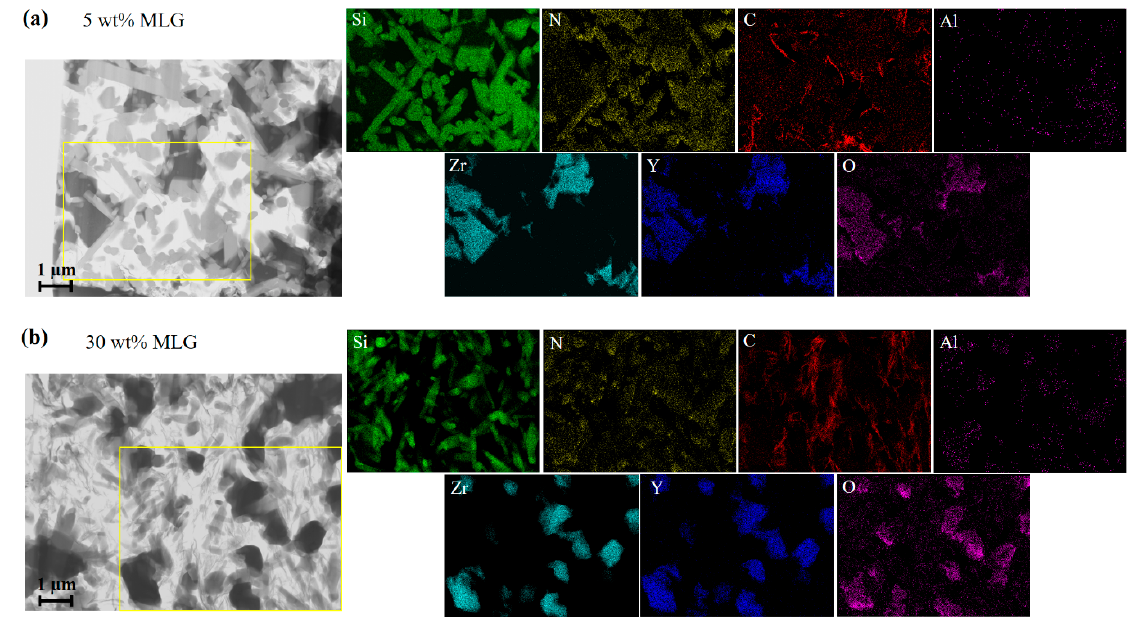
Figure 3. TEM image and corresponding elemental maps of the sintered composites. ( a ) With 5 wt.%, ( b ) with 30 wt.%.